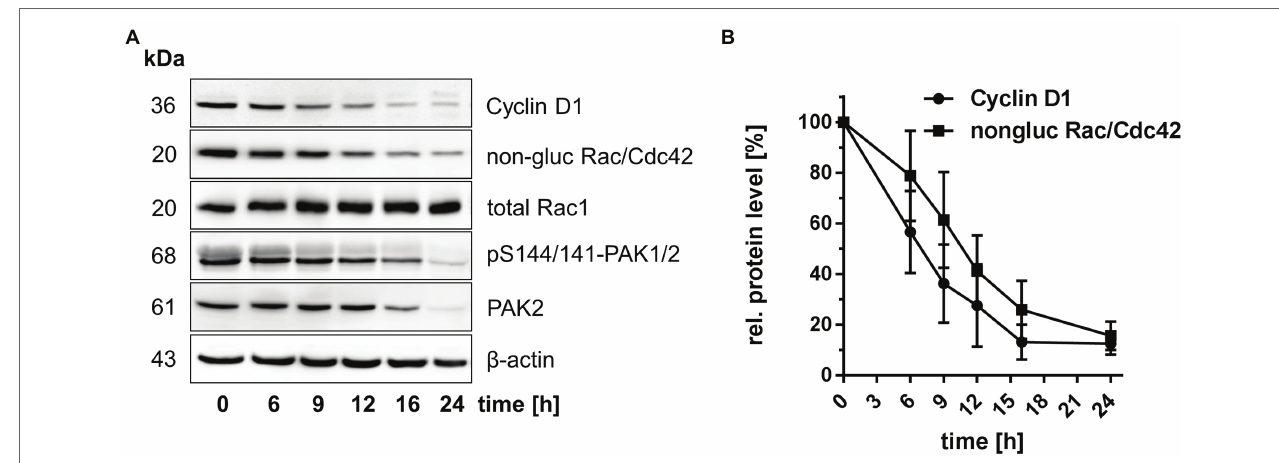
FIGURE 1 | Suppression of Cyclin D1 in TcdB-treated human intestinal organoids (HIOs). (A) HIOs were treated with TcdB (30 ng/ml) for the indicated times. The relative cellular concentrations of the indicated proteins were determined using Western blot analysis. Representative Western blots are presented. (B) Quantifications of signals were performed using Kodak software. Signal intensities obtained from immunoblots blots (n = 3) were quantified and normalized to the signal of beta-actin. The concentration of the indicated proteins in non-treated cells was set 100. Values are given as mean ± SD of three independent